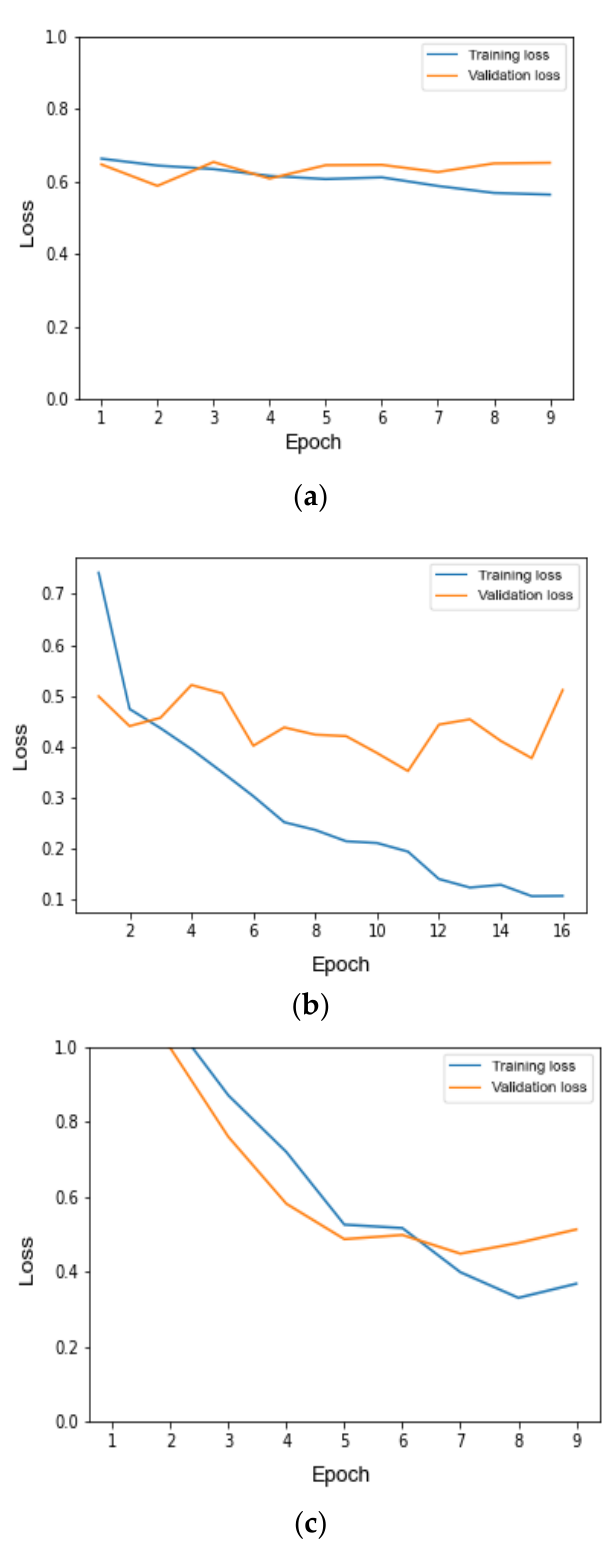
Figure 3. Training/validation loss per epoch using the CNN-based variant for time slice classification on: ( a ) UAH, ( b ) MOTIF 1 and ( c ) MOTIF 2 datasets.